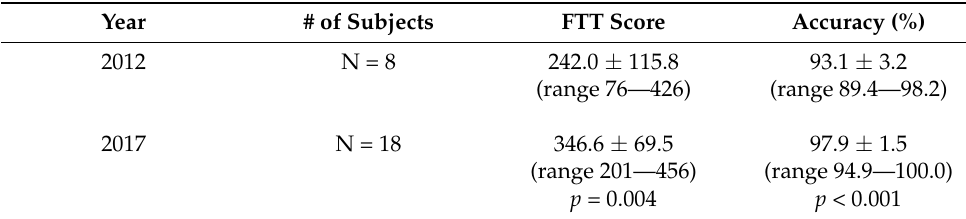
Table 1. Comparison of pilot data collected from 2012 versus the data collected for this study (2017). None of the data was used twice. P-value listed at the bottom of the